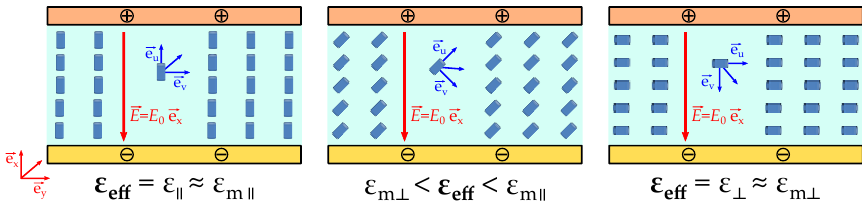
Figure 4. Idealized parallel-plate capacitor with LC as dielectric filling for the three cases defined in Equation (7), ( Left ) (cid:126) e u ~ e x , (Right) ~ e u ~ e y , and (Center) “else”. Note: Interface effects between LC and electrodes are neglected for simplification.